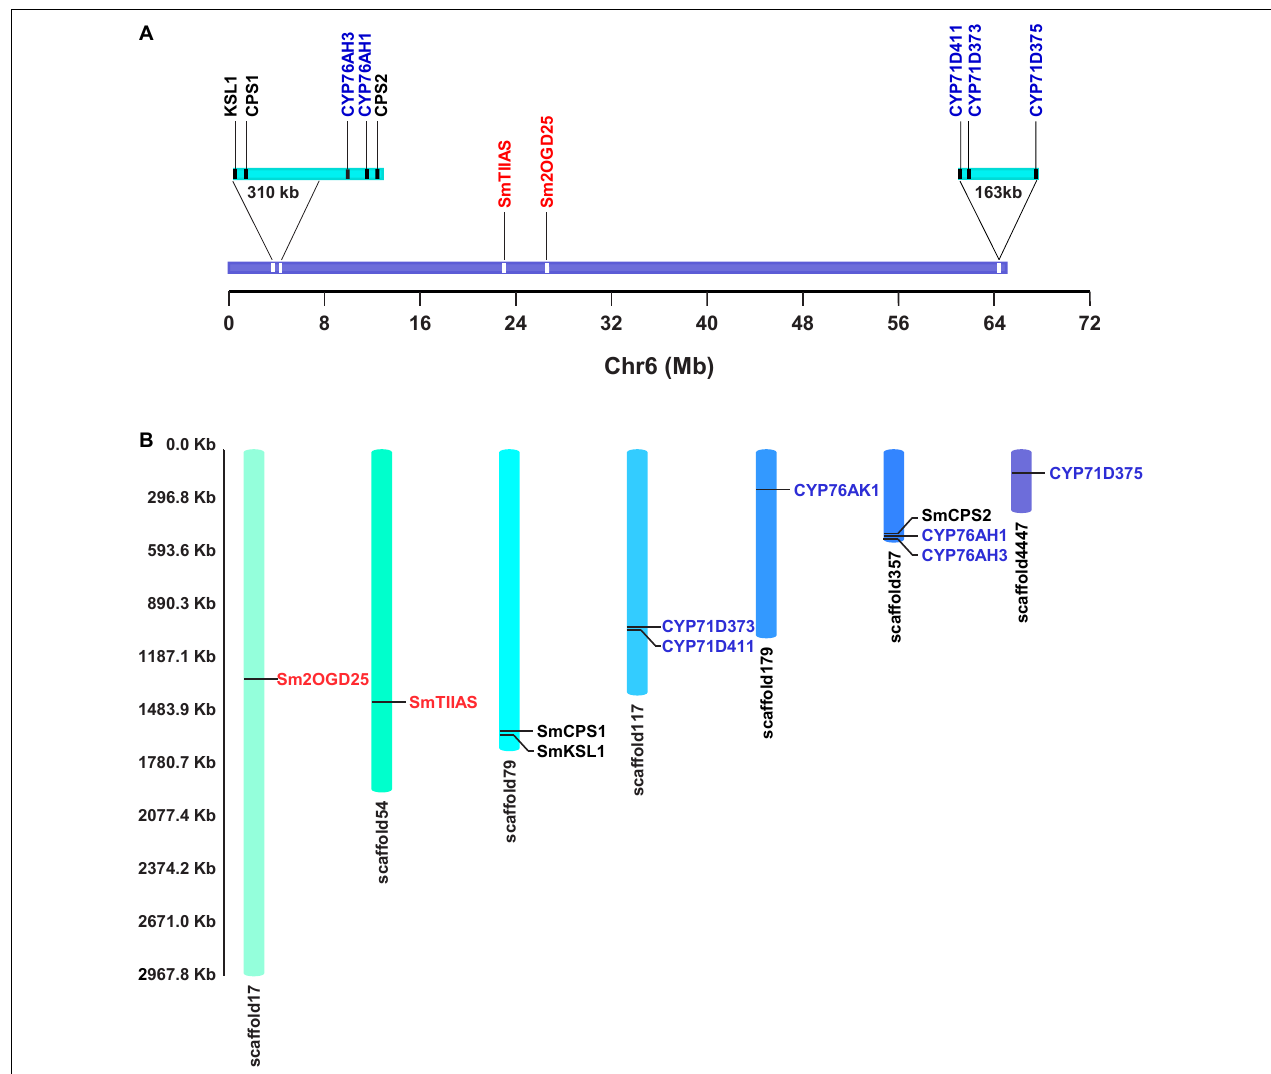
FIGURE 2 | The positions of identified genes on pseudochromosome 6 and scaffolds. (A) Gene location of identified diTPS , CYP450 , and 2OGD genes on pseudochromosome 6. (B) The positions of 11 identified genes on scaffolds. Genes in black, blue, and red are functional diTPS , CYP450, and 2OGD genes.